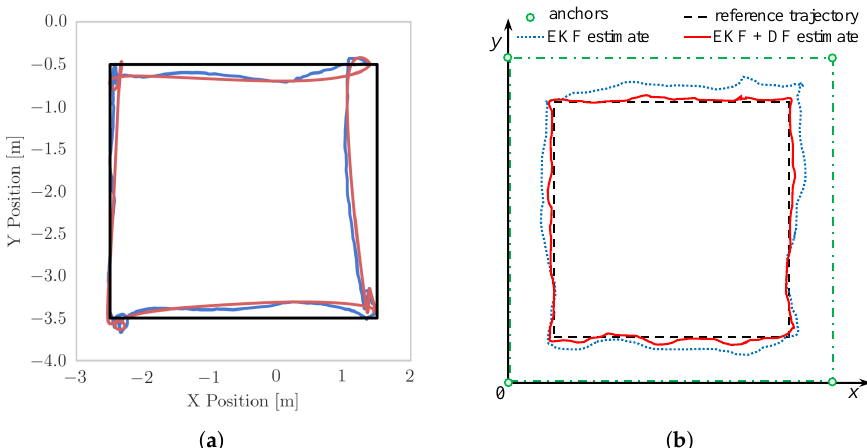
Figure 14. Square path experiments ( a ) from [57] and ( b ) carried out in this paper. ( a ) Drone flying in auto-pilot along a desired square path (black) (from [57]). Both the EKF estimate (blue) and the actual position (red) are shifted from the desired path. ( b ) Proposed experiment following a fixed square path (black). The EKF + DF estimation (red) is expected to be more accurate than the EKF-only estimation